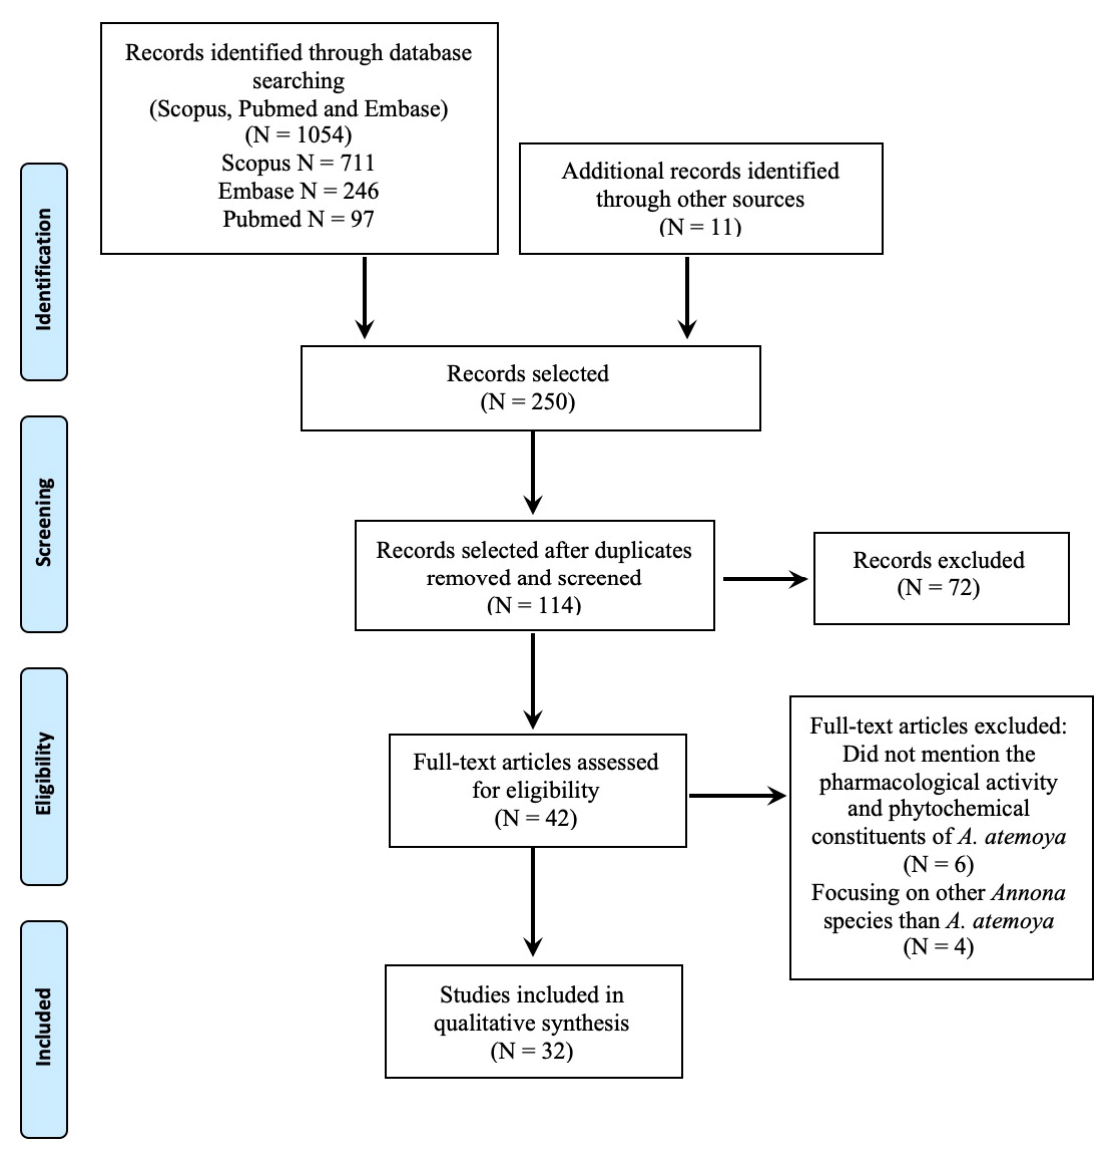
Figure 1. Preferred Reporting Items for Systematic Reviews aand Meta-Analyses (PRISMA) flowchart of literature search strategy and results.